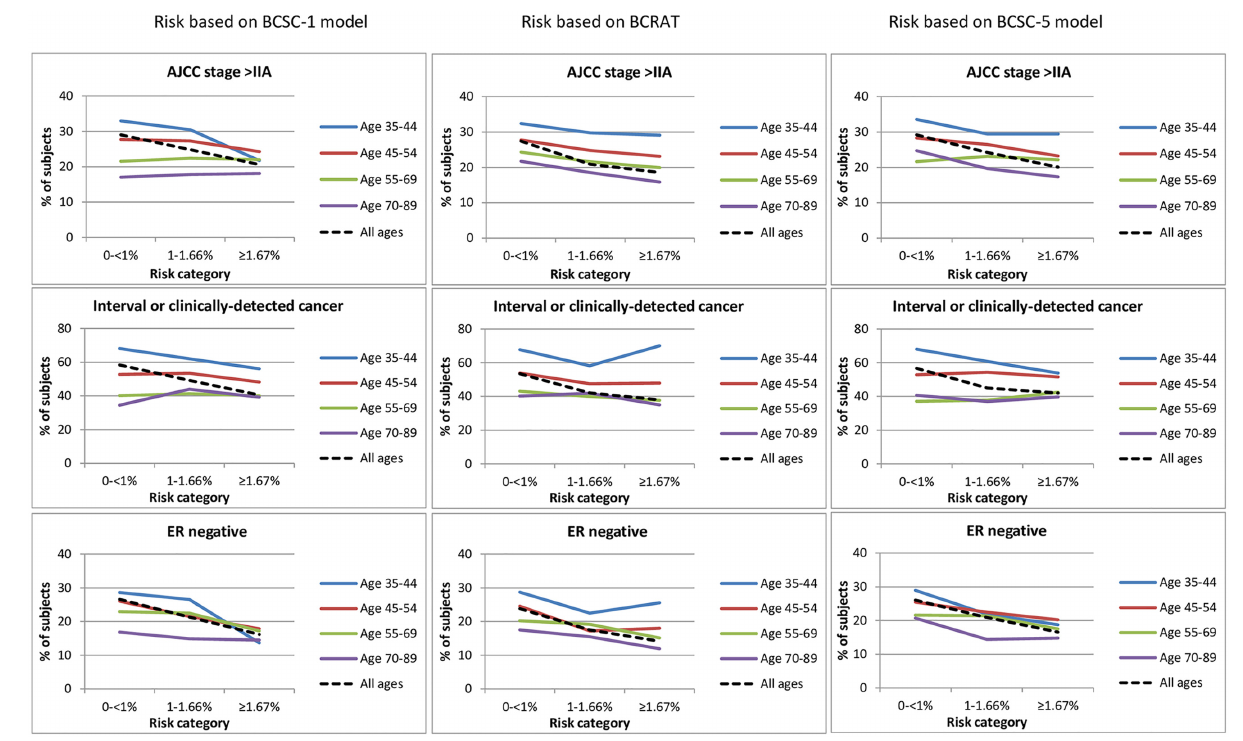
Fig 2. Predicted 5-year risk of developing breast cancer versus clinicopathologic characteristics.